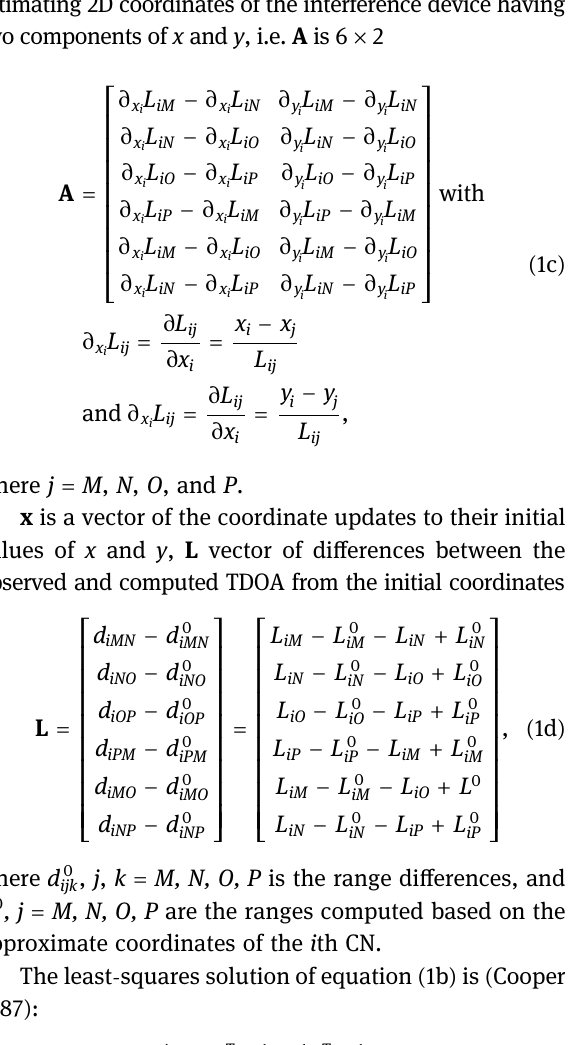
Figure 1: Interference localisation security network with four